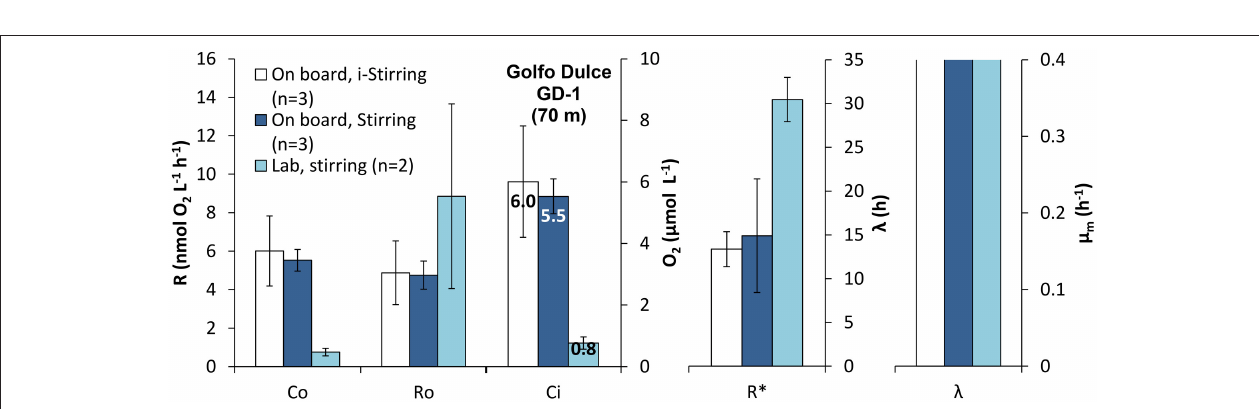
FIGURE 8 | Effect of sample handling and treatment on the respiratory parameters during the incubation of intermediate waters in Golfo Dulce OMZ: Initial respiration rates ( R 0 ), maximum respiration rate ( R *), initial Oxygen concentration ( C 0 ), lag-phase ( λ ), and maximum specific growth rate ( µ m ) measured during the incubations. Samples were collected by Niskin bottles and transferred immediately and directly to the incubation bottles on board (On board). Once in the laboratory, the bottles were kept at constant temperature with only intermittent (i-Stirred) or with stirring (Stirred). A water sample from the same depth was collected and transported to the laboratory where it was sparged with inert gas to lower the O 2 concentration and incubated with constant stirring (Stirred).